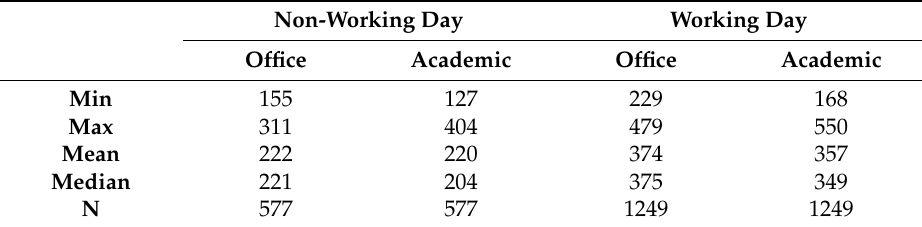
Table 3. Statistics of electricity consumption (Wh/m 2 ) on working and non-working days. Non-Working Day Working Day Office Academic Office